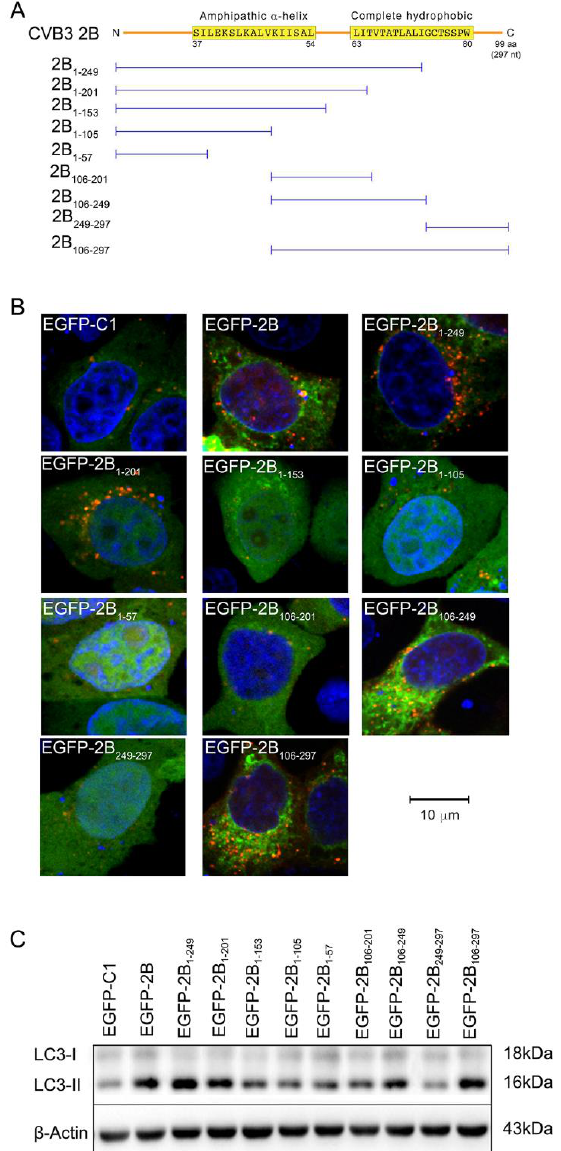
Figure 3. The autophagy-inducing motif of protein 2B. ( A ) The diagram shows the constructs expressing truncated protein 2B fused with EGFP (not included in the plot); ( B ) HeLa cells were co-transfected with pEGFP-2B XX (representing the truncated 2B) and pmCherry-LC3 for 42 h and treated with E64-D/PEPA (10 ng/mL) for 6 h. The control cells were transfected with pEGFP-C1 and pmCherry-LC3. Cells were observed by confocal microscope (×600); ( C ) HeLa cells were treated as described in ( B ). EGFP and LC3 were detected by Western blotting. n = 4. Experiment was repeated three times. Representative images were presented.